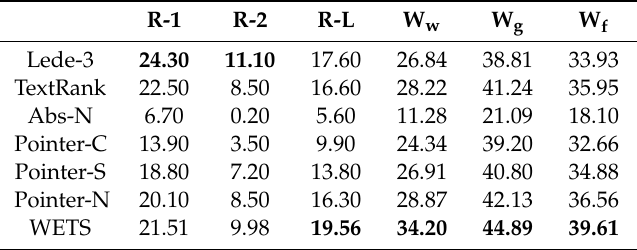
Table 5. ROUGE variants (R-1, R-2 and R-L) and WEEM4TS variants (W w , W g and W f ) scores of WETS and six baseline text summarization systems. We used W w , W g , and W f that stand for Word2Vec, GloVe and FastText based variants of WEEM4TS respectively. The best results are in